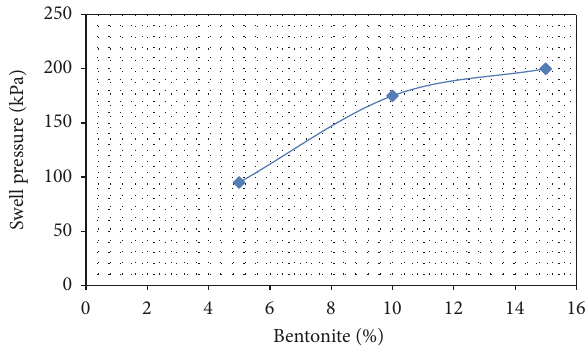
Figure 5: Swelling pressure for different bentonite contents in the